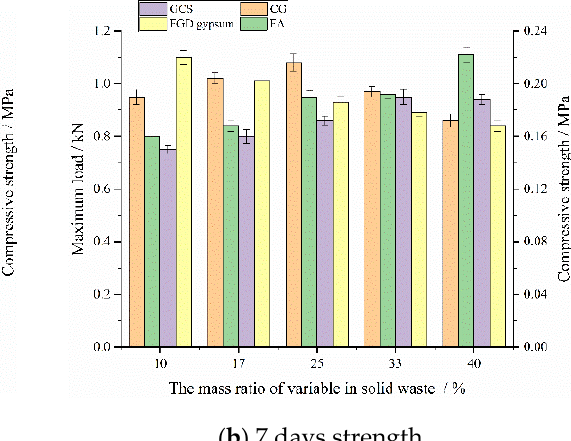
GCS is not conducive to early strength growth. The mass ratio of FGD gypsum